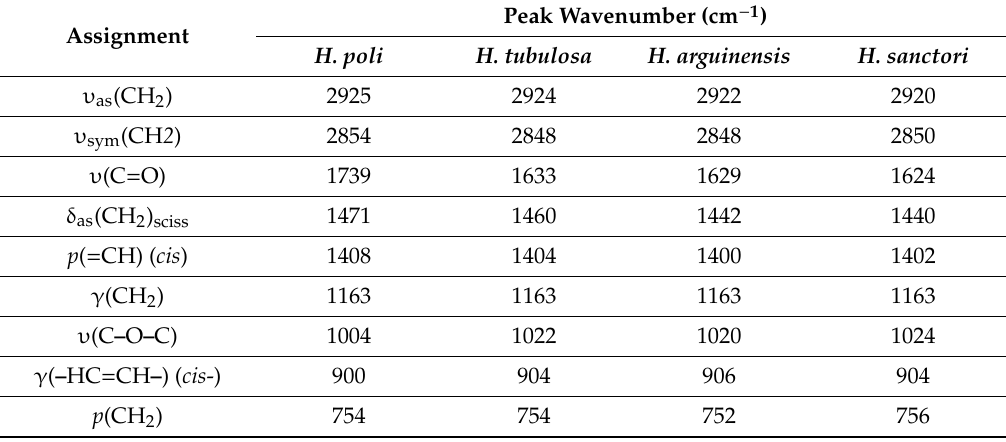
Table 5. General peak Wavenumber (cm − 1 ) and assignments of the FTIR spectra of vibration of the four sea cucumbers oils in the wave number range of 4000–400 cm − 1 . Peak Wavenumber (cm − 1 Assignment